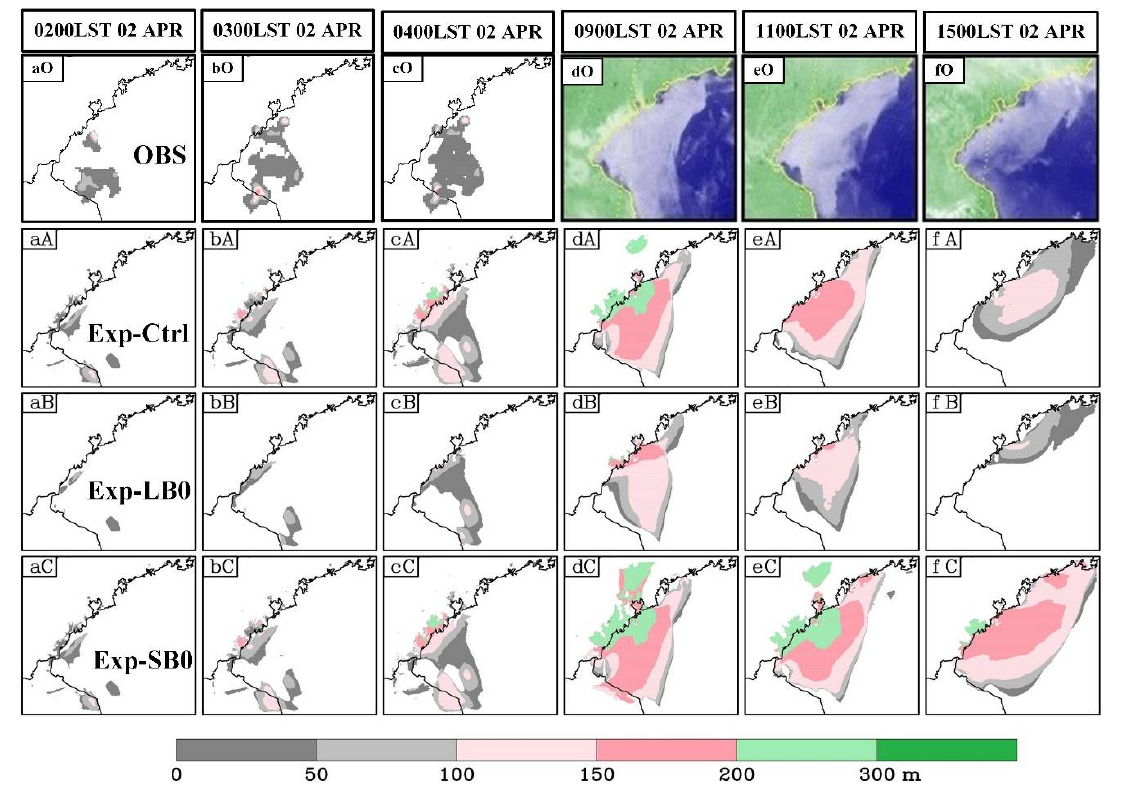
Figure 6. Comparison of the observed sea fog (top row; aO – fO ) and the simulated sea fog. From the second row, the results of Exp-Ctrl ( aA – fA ), Exp-LB0 ( aB – fB ), and Exp-SB0 ( aC – fC ) are shown, respectively. Color shades represent the simulated fog-top height (i.e., fog depth; m).